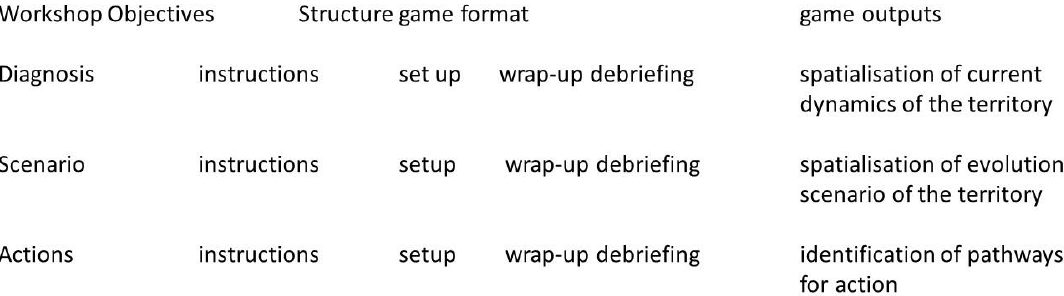
Figure 3. Overview of the workshop structure.